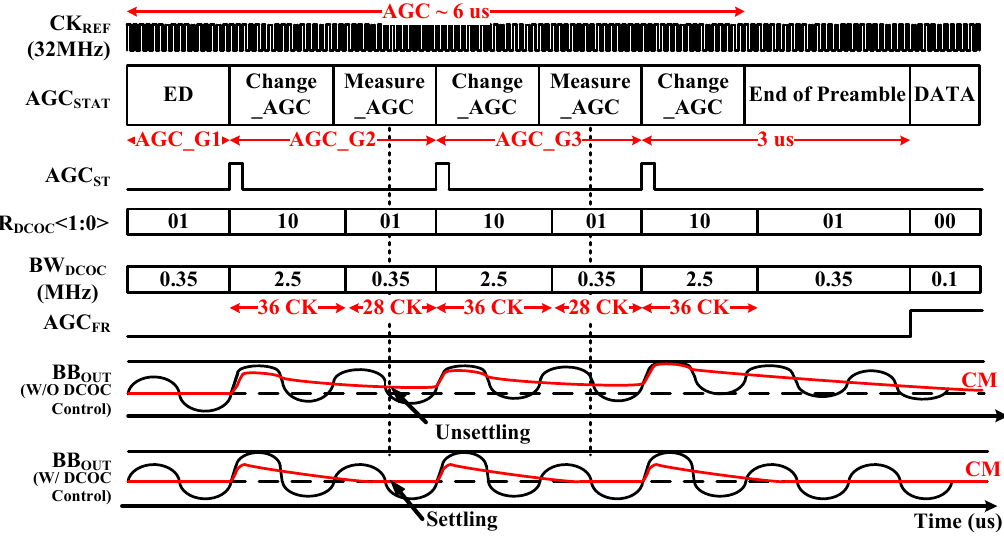
Figure 7. Timing diagram of the DCOC Controller.